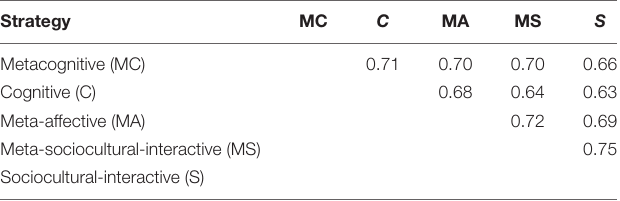
TABLE 5 | HTMT ratio of the correlations for the factors.